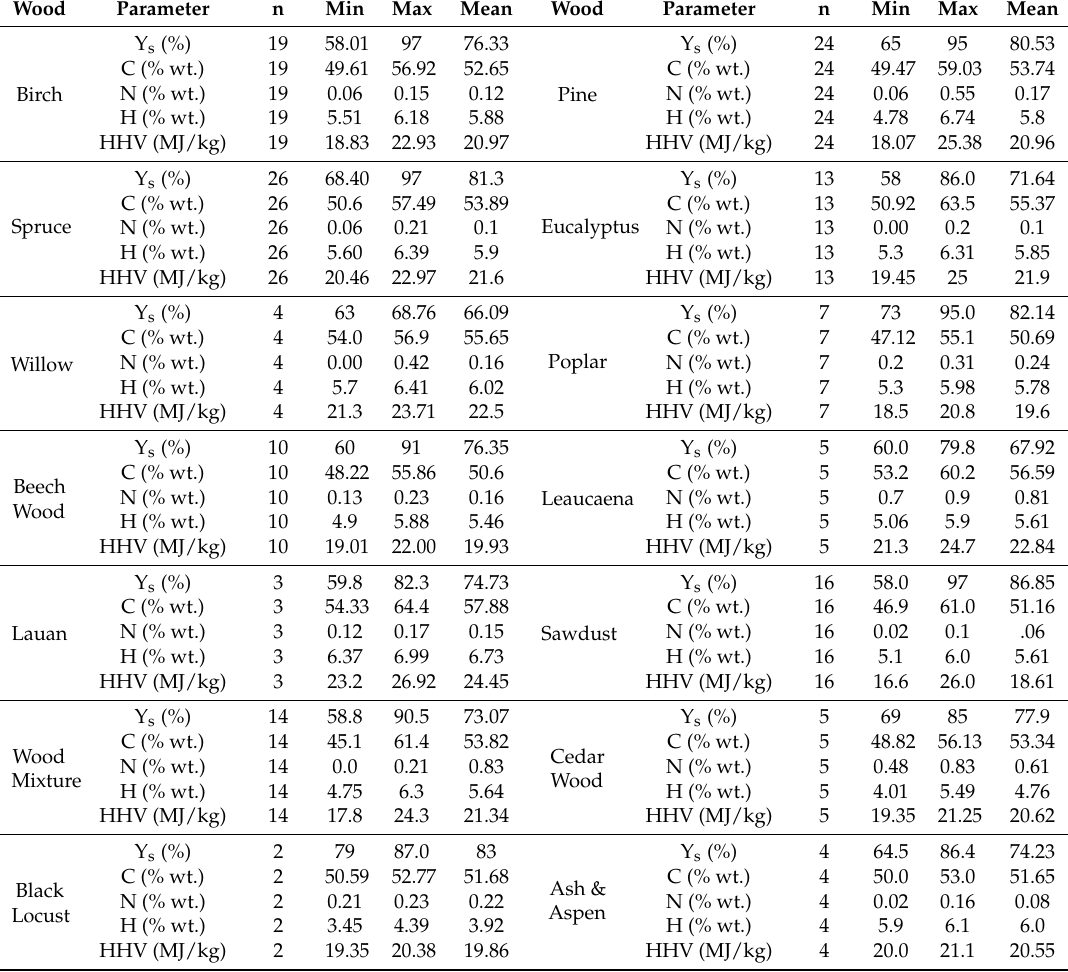
Table 2. Summary of the collected data (dry and ash free) categorized by the wood type. Wood